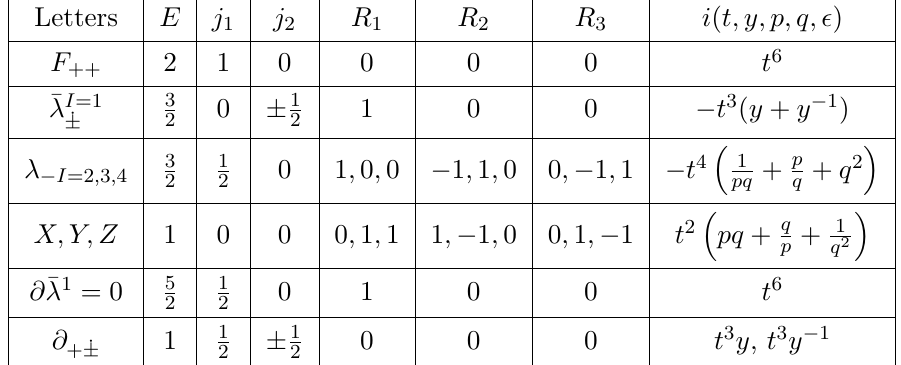
Table 1 . The on-shell degrees of freedom of the N = 4 (cid:12)eld strength multiplet are F (cid:11)(cid:12) , e F (cid:22) (cid:21) I , (cid:30) IJ with I = 1 ; 2 ; 3 ; 4 and (cid:30) IJ is in the [ 0 ; 1 ; 0 ] of su (4). We de(cid:12)ne X = (cid:30) 12 , Y = (cid:30) 13 and _ (cid:11) Z = (cid:30) 14 . @ (cid:22) (cid:21) 1 denotes the equation of motion @